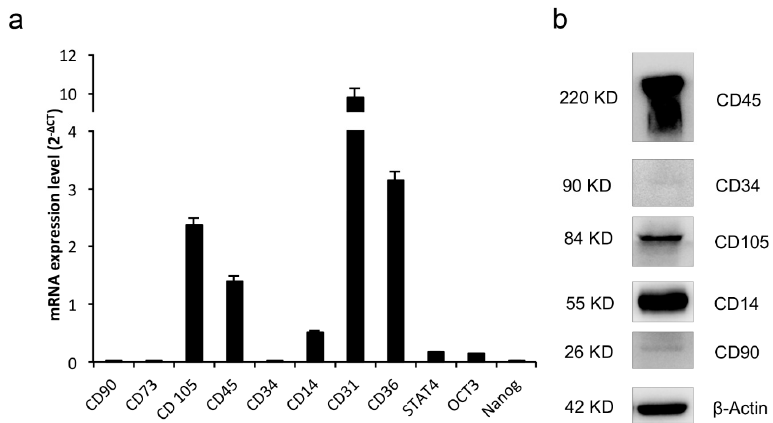
Figure 7. Gene expression of cell surface and pluripotent markers. ( a ) mRNA was quantified by real-time PCR in CGF primary cells. The comparative CT method (2 – Δ CT ± SD) was used to quantify the gene expression level. Gapdh was used as a housekeeping gene. The results are expressed as the mean ± SD of triplicate measurements from four independent experiments. ( b ) Expression of stem cell surface proteins. β -Actin was used as an internal loading control. The image is representative of three independent experiments.